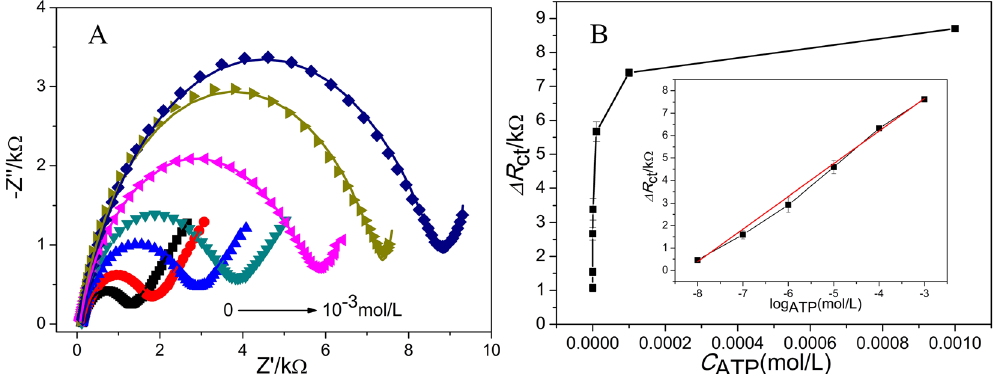
Figure 4. ( A ) Nyquist plots of the Au electrode modified with Ce-MOF-apt after incubation with different concentrations of ATP (0, 10 − 8 mol·L − 1 , 10 − 7 mol·L − 1 , 10 − 6 mol·L − 1 , 10 − 5 mol·L − 1 , 10 − 4 mol·L − 1 , 10 − 3 mol·L − 1 ); ( B ) Dependence of Δ R ct on ATP concentrations. Inset: Δ R ct is linear with the logarithm of ATP concentrations ranging from 10 − 8 to 10 − 3 mol·L − 1 .